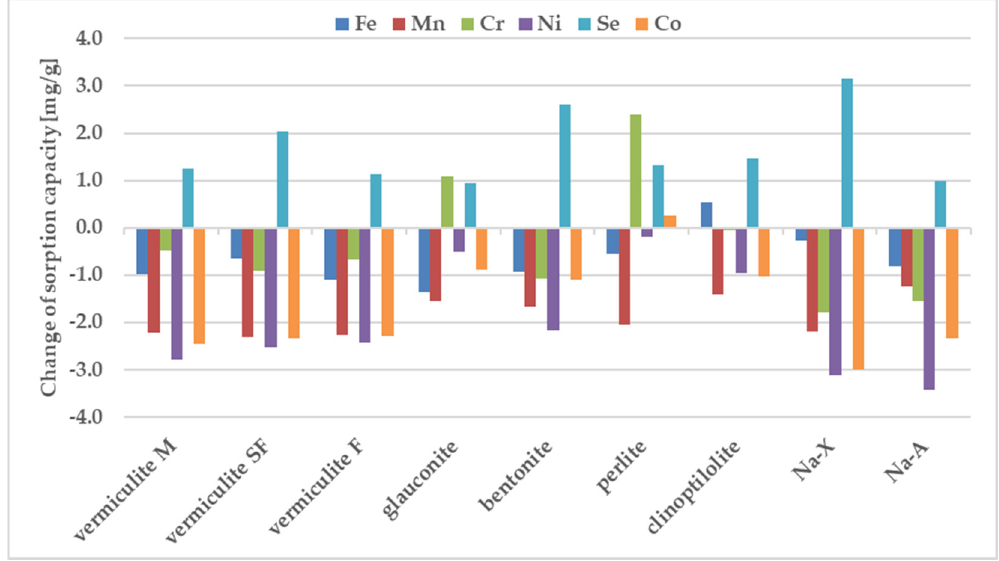
Figure 4. Change of sorption under influence of other ions, estimated in batch study. For experimental conditions see the label for Figure 2.